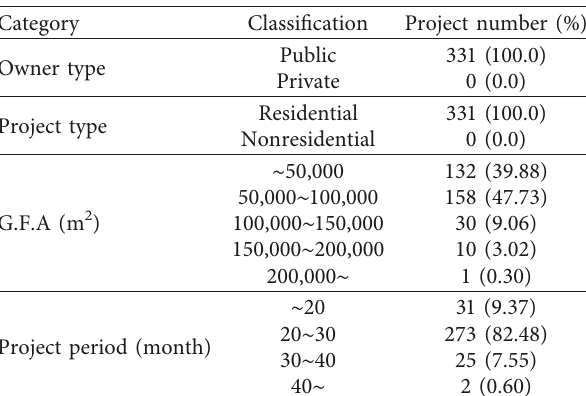
Table 1: Basic information of sample projects.